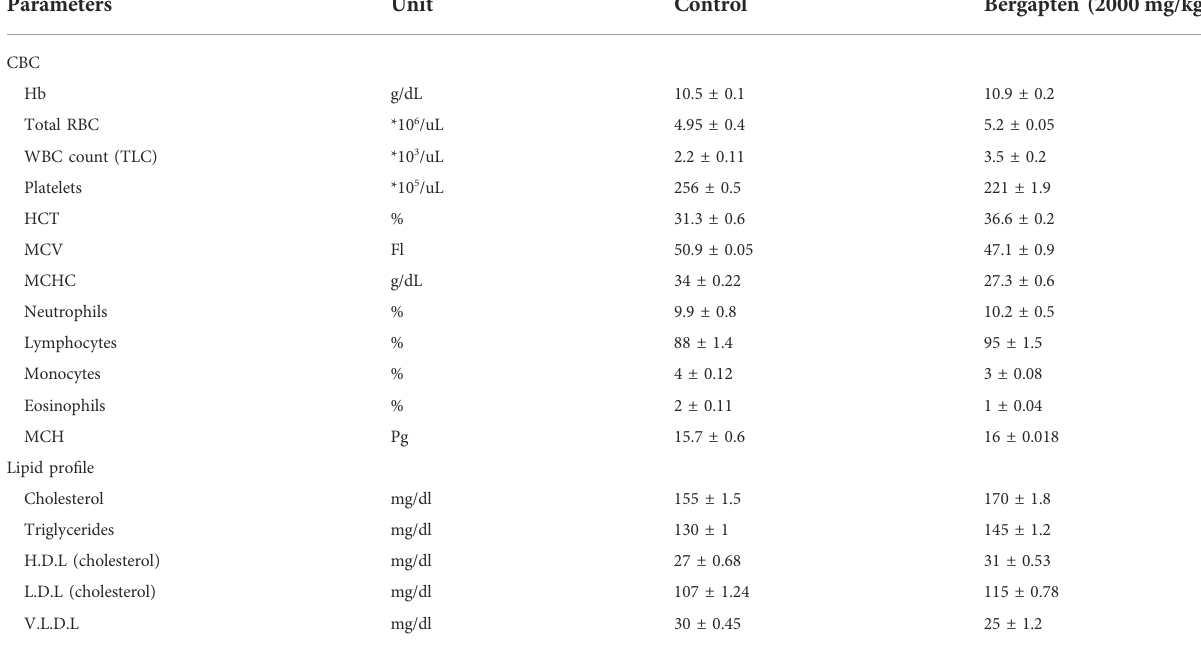
TABLE 6 Effect of bergapten (at limit dose 2000 mg/kg b.w. p.o) on the complete blood count (CBC) and lipid pro fi le of control group